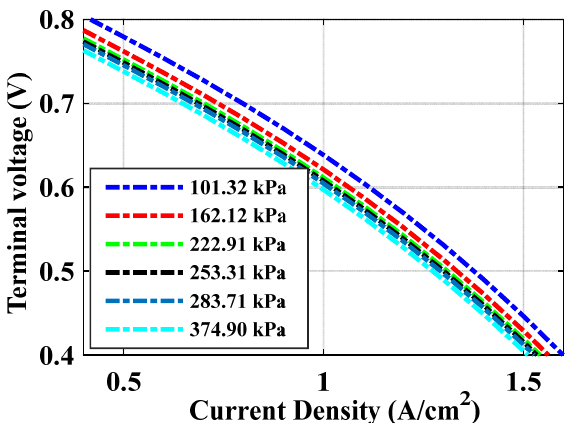
Figure 4. FC terminal voltage as a function of oxygen pressure at the cathode.